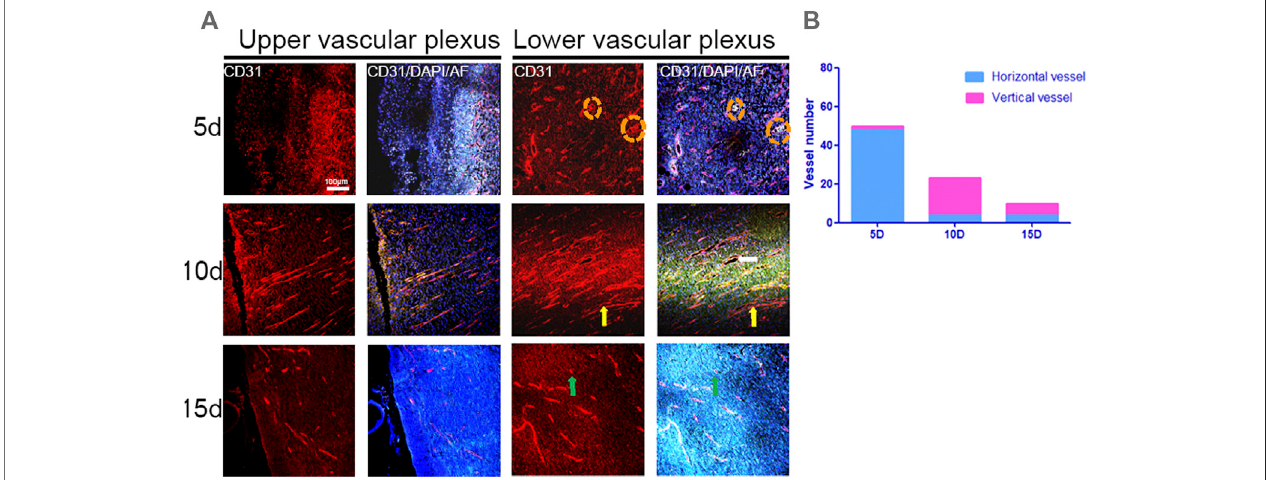
FIGURE 9 | IF images of CD31 and statistical graphs of blood vessels in the longitudinal plane in the center of the wound. (A) IF images of super fi cial and deep dermal vessels at different times during wound healing (red: CD31, blue: DAPI, green: auto fl uorescence, yellow arrows: vertical vessels, green arrows: orange, and dotted circles: thick vessels). (B) Number of blood vessels.